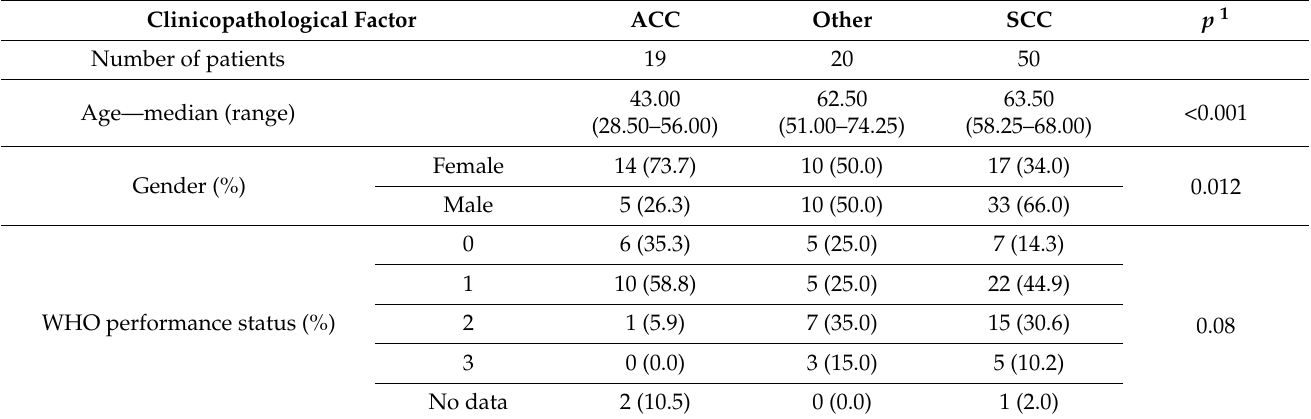
Table 3. Demographic and clinical characteristics of 89 patients diagnosed with primary tracheal neoplasm by histological